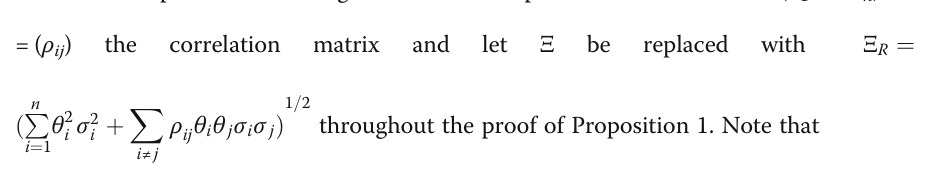
Table 5 Value-at-Risk for a portfolio of two assets (correlation ρ = - 0.5) c =